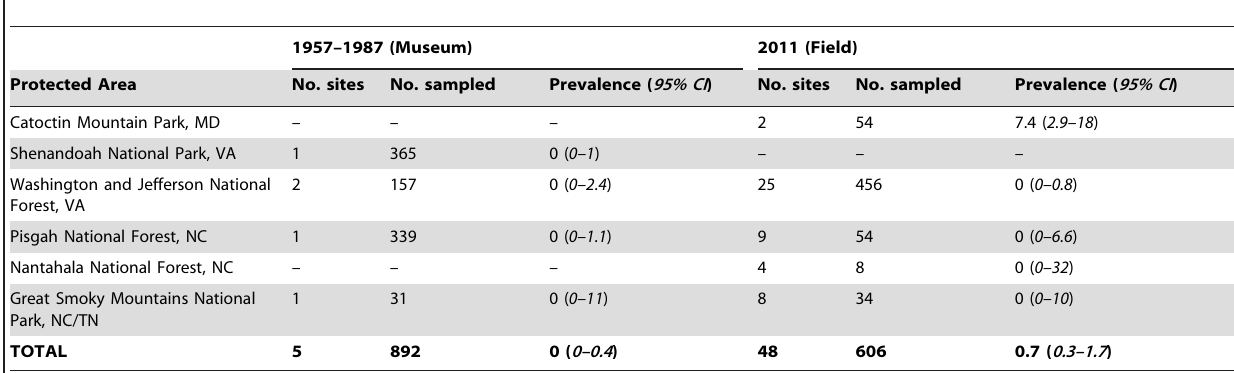
Table 2. Results of Bd testing for six protected areas in the Appalachian